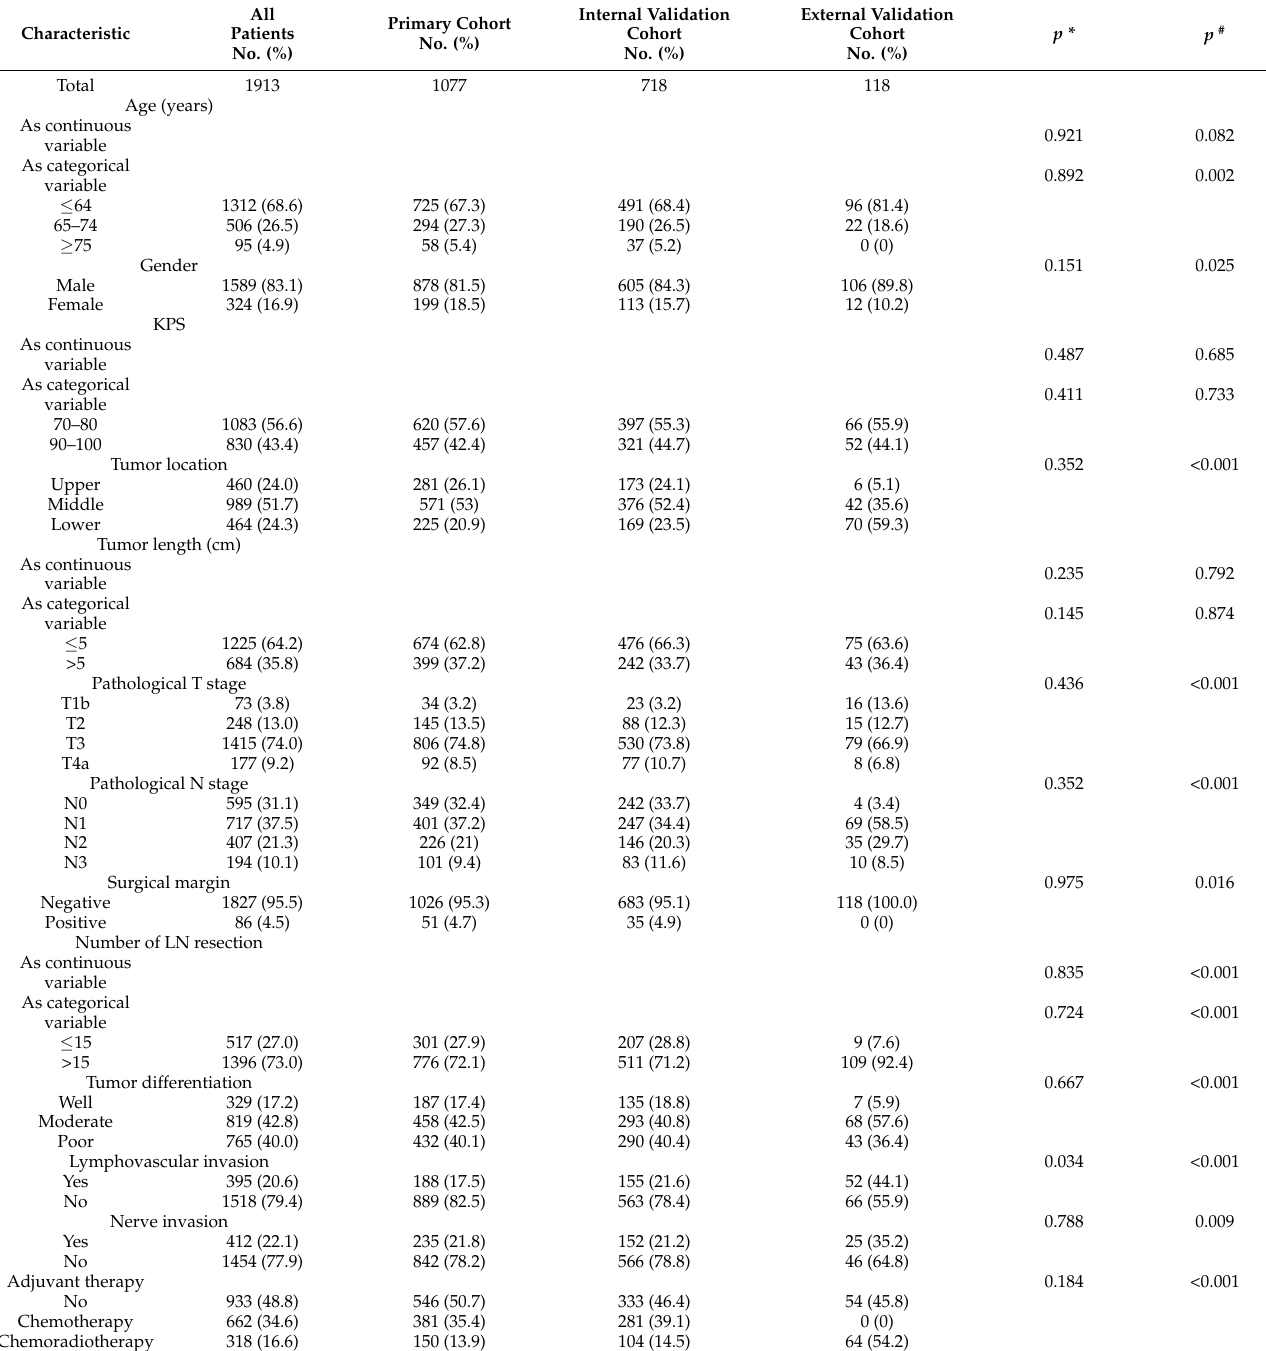
Table 1. Clinicopathological